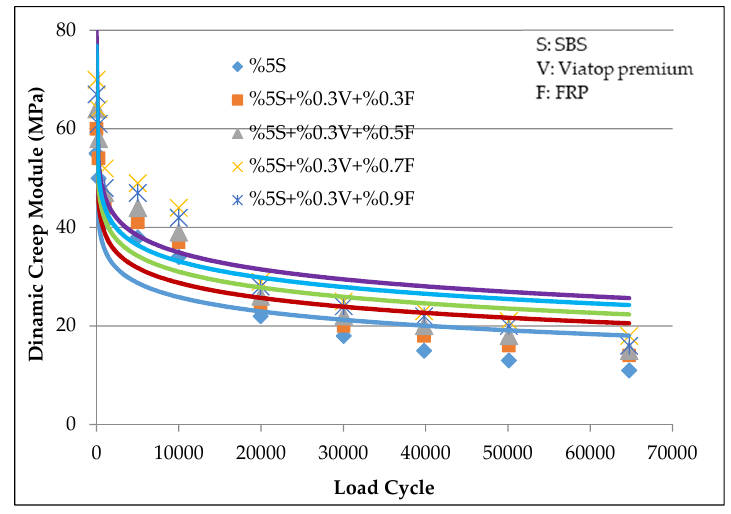
Figure 13. Dynamic Creep Modulus-Load Repetition.